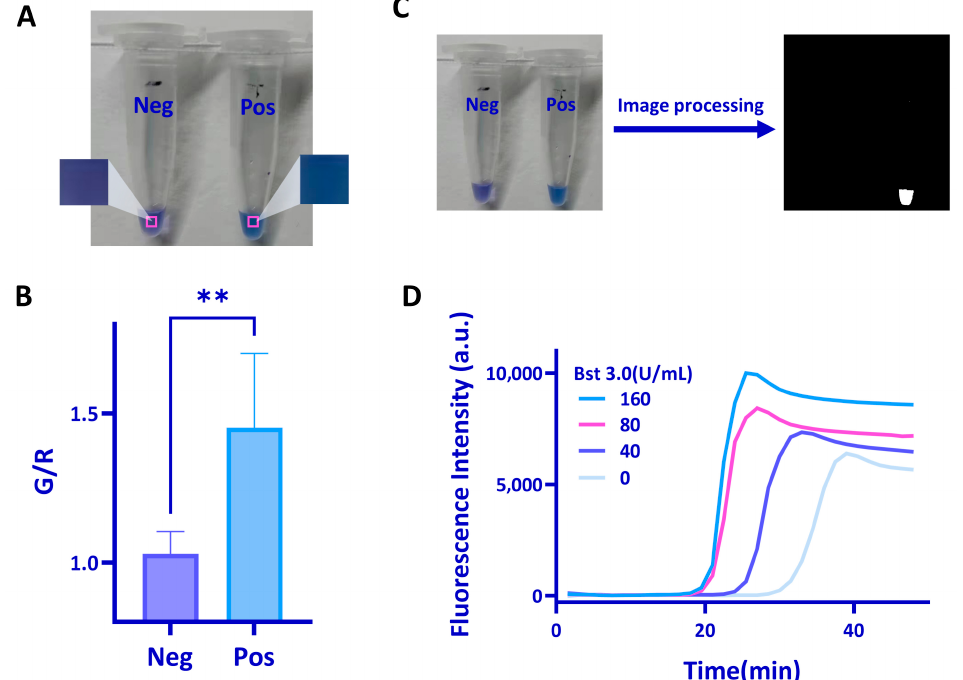
Figure 3. Feasibility test of the system. ( A ) Image analysis of the positive and negative samples. ( B ) G/R ratio of negative and positive samples calculated from images taken with a cellphone. The statistical analyses were performed using t -test, two-tailed, where ns = not significant with p > 0.05, the ** denotes significant differences with p values between 0.0001 to 0.001. ( C ) The images before and after G/R processing. ( D ) Real-time amplification curve of RT-LAMP with different concentrations of